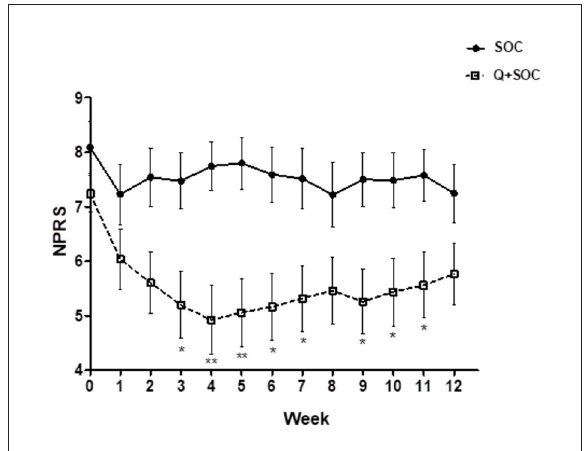
FIGURE3 Time–course graph of spontaneous pain scores over 12 weeks in the two study groups, capsaicin 8% patch Qutenza (Q) plus Standard of Care group (PDPN Q + SOC; n = 25), and Standard of Care group (PDPN SOC alone; n = 12). Separate assessment of pain scores at each week time point showed a significant difference in NPRS scores at week 3 (* p < 0.05), week 4 (** p < 0.05), week 5 (* p < 0.05), week 6 (* p < 0.05) and week 9 (* p < 0.05; two–way ANOVA analysis).